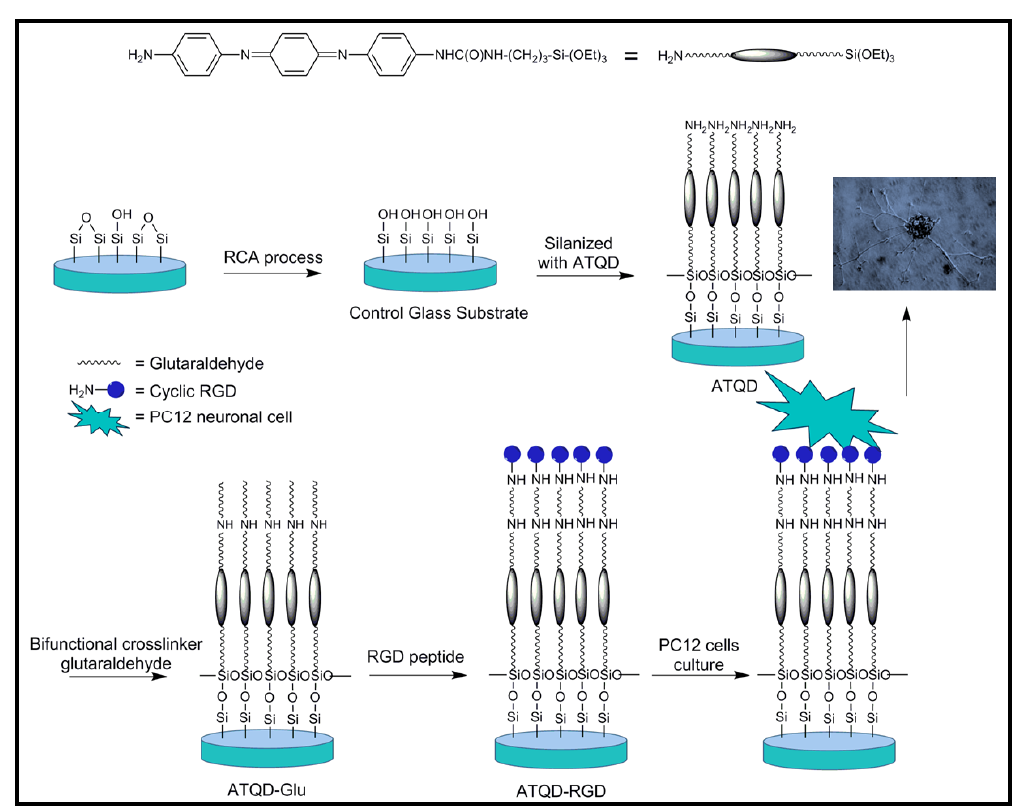
Figure 6. Scheme showing the preparation of self-assembled monolayers of ATQD-RGD, inset reproduced with permission from [41]. Copyright 2007 American Chemical